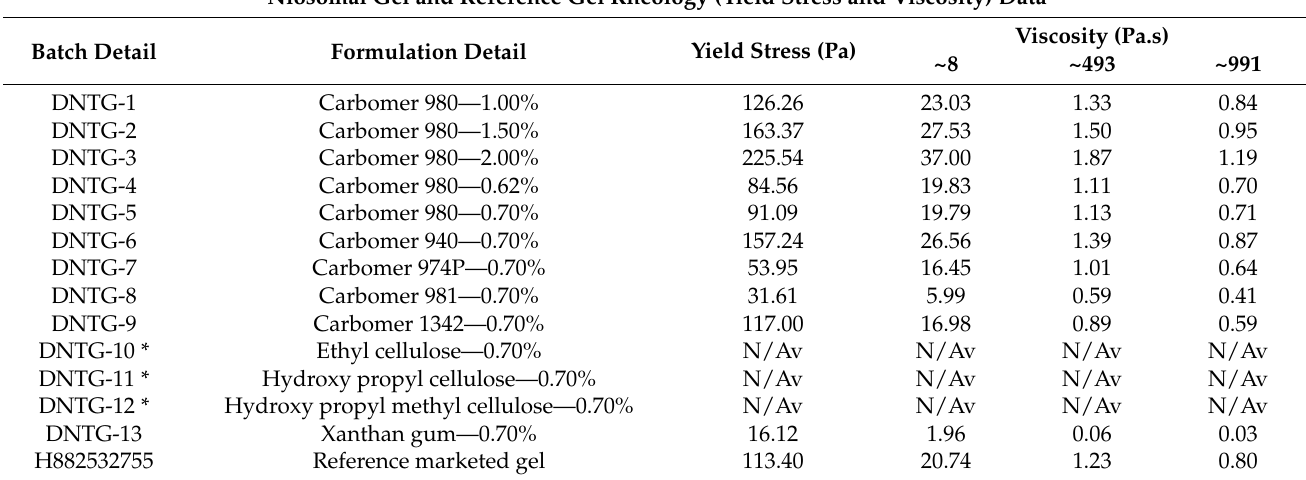
Table 6. Yield stress and viscosity data for niosomal gel and reference gel drug products. Niosomal Gel and Reference Gel Rheology (Yield Stress and Viscosity) Data